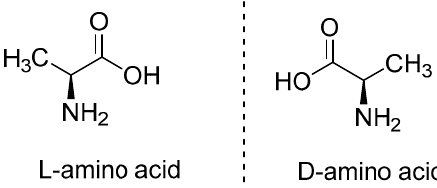
l - and d - of an amino Figure 3. Two enantiomeric forms, L ‐ and D ‐ of an amino acid. Figure 3. Two enantiomeric forms, Figure 3. Two enantiomeric forms, L ‐ and D ‐ of an amino acid.